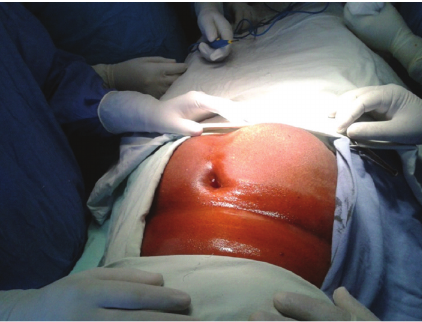
Figure 3: CECT Cyst with internal undulating septae.